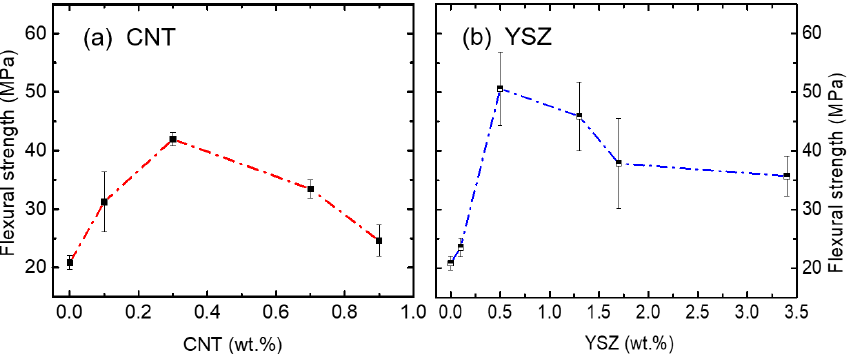
Figure 5. Flexural strength of ( a ) CNT- and ( b ) YSZ-added specimens as a function of additive amounts. The flexural strength increases up to 41.9 ± 1 MPa when 0.3 wt.% of CNT is added and decreases significantly thereafter. Whereas the 0.5 wt.% YSZ-added specimen shows a maximum flexural strength of 50.6 ± 6 MPa and maintains its strength higher than a value of 35.7 ± 3 MPa after increasing YSZ content to 3.4 wt.%. To evaluate the strength essentially for dental applications, Rockwell hardness was measured mainly at three locations (top, side, and bottom sides) of the 3D-printed teeth. Rockwell hardness data of both the CNT- and YSZ-added samples were compared at the same scale in Figure 6. The hardness values are comparable for all three locations, and this demonstrates that the 3D-printed teeth possess uniform strength in all directions.